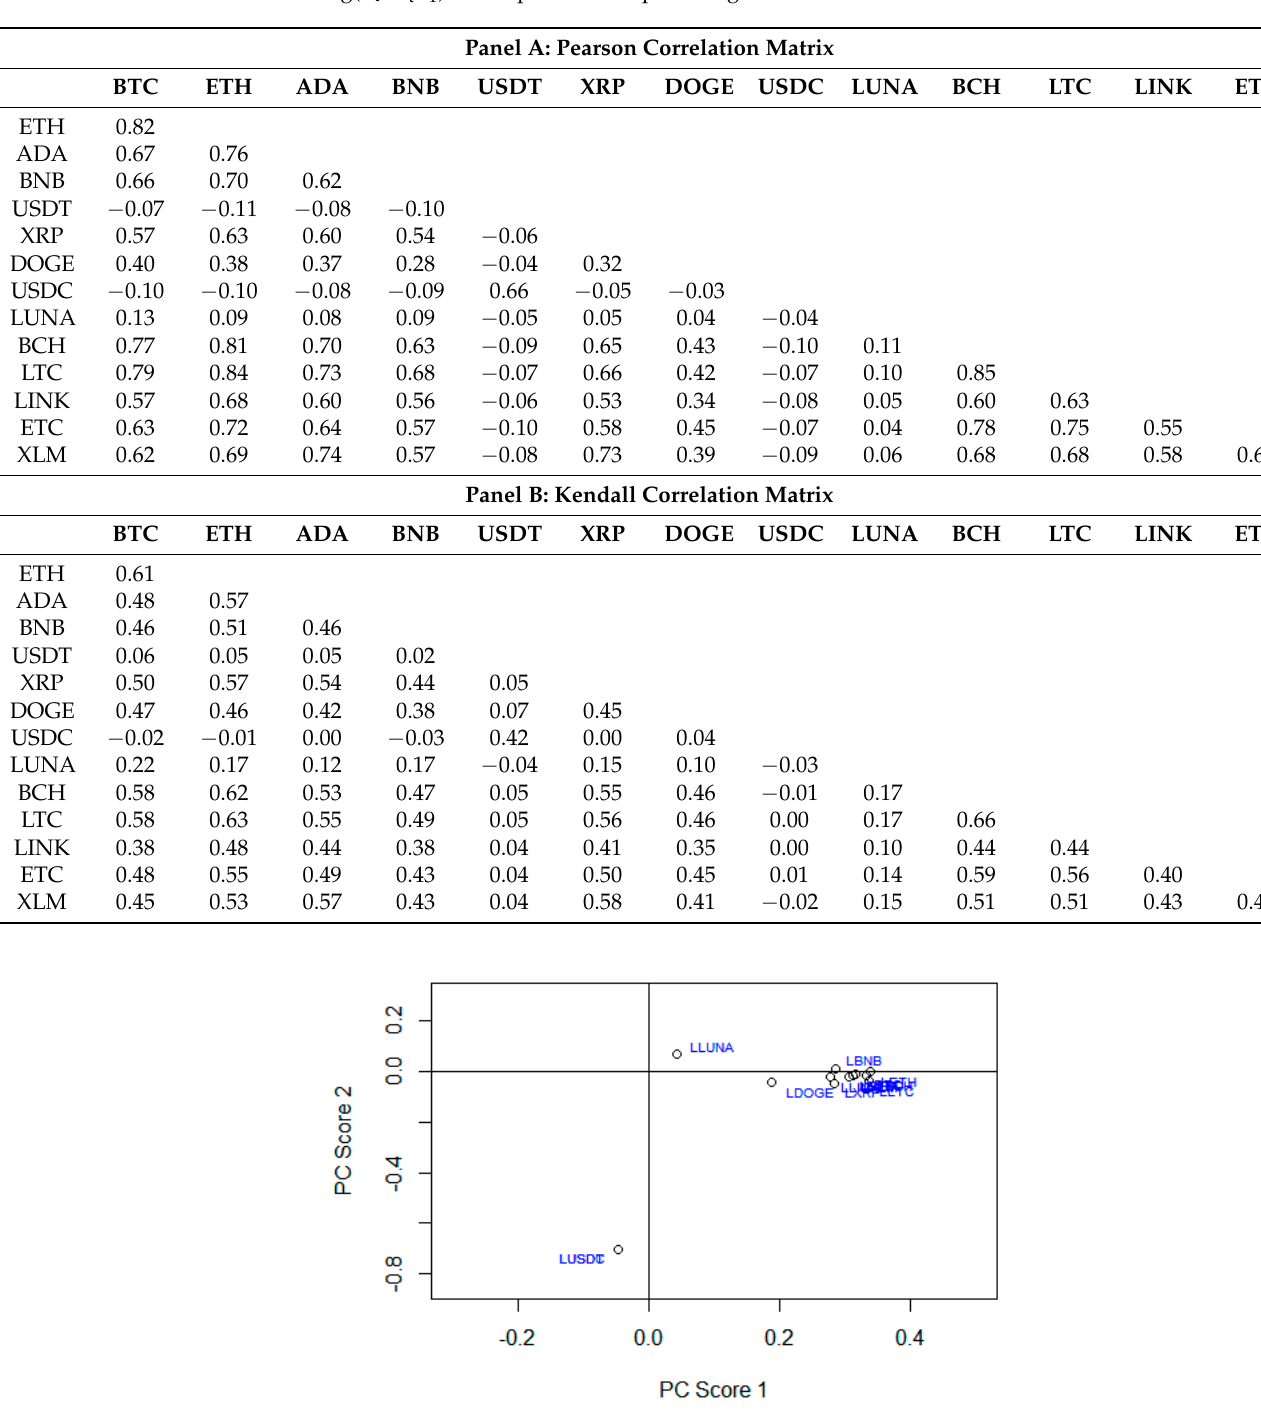
Table 3. Correlation Tables. Data range is from 1/1/2019 to 8/27/2021. Each variable is calculated as log(P t /P t − 1 ) and expressed as a